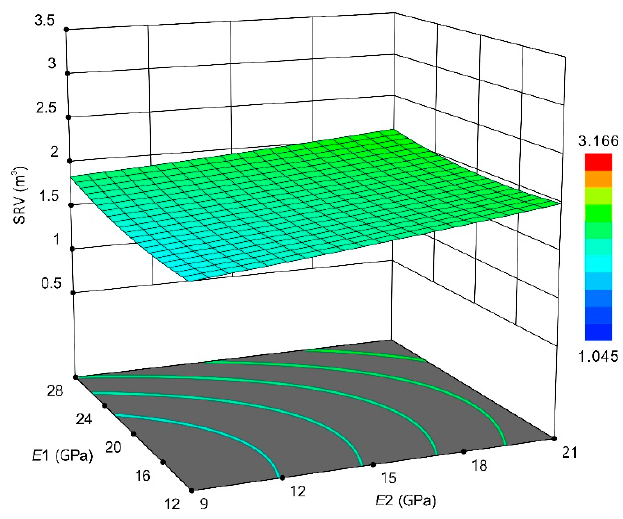
Figure 13. Response surface of the interaction between E 1 and E 2 to SRV.